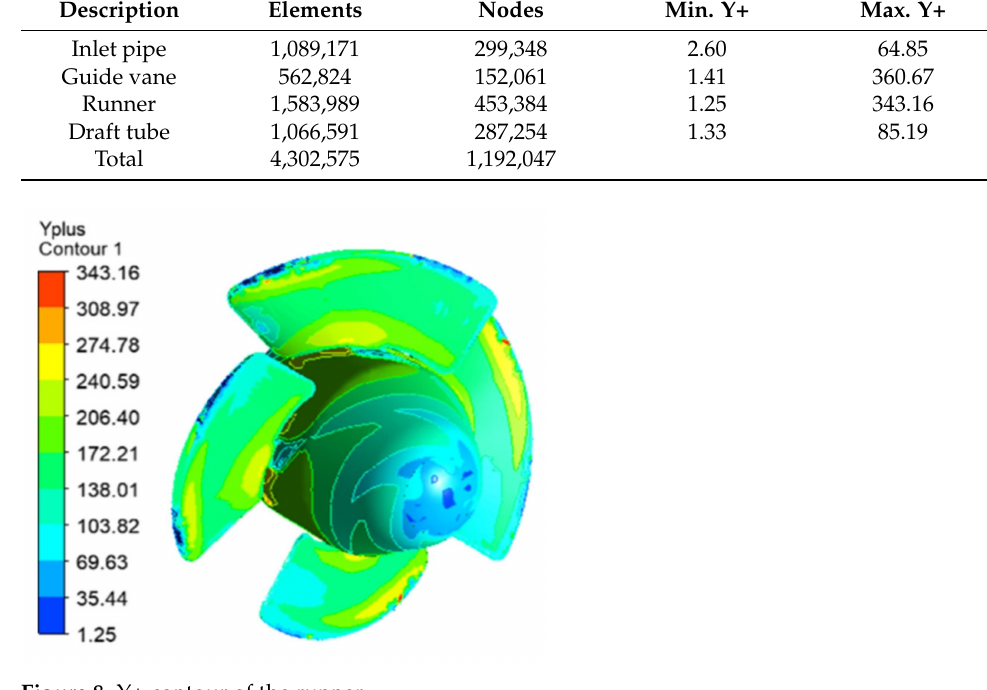
Figure 8. Y+ contour of the